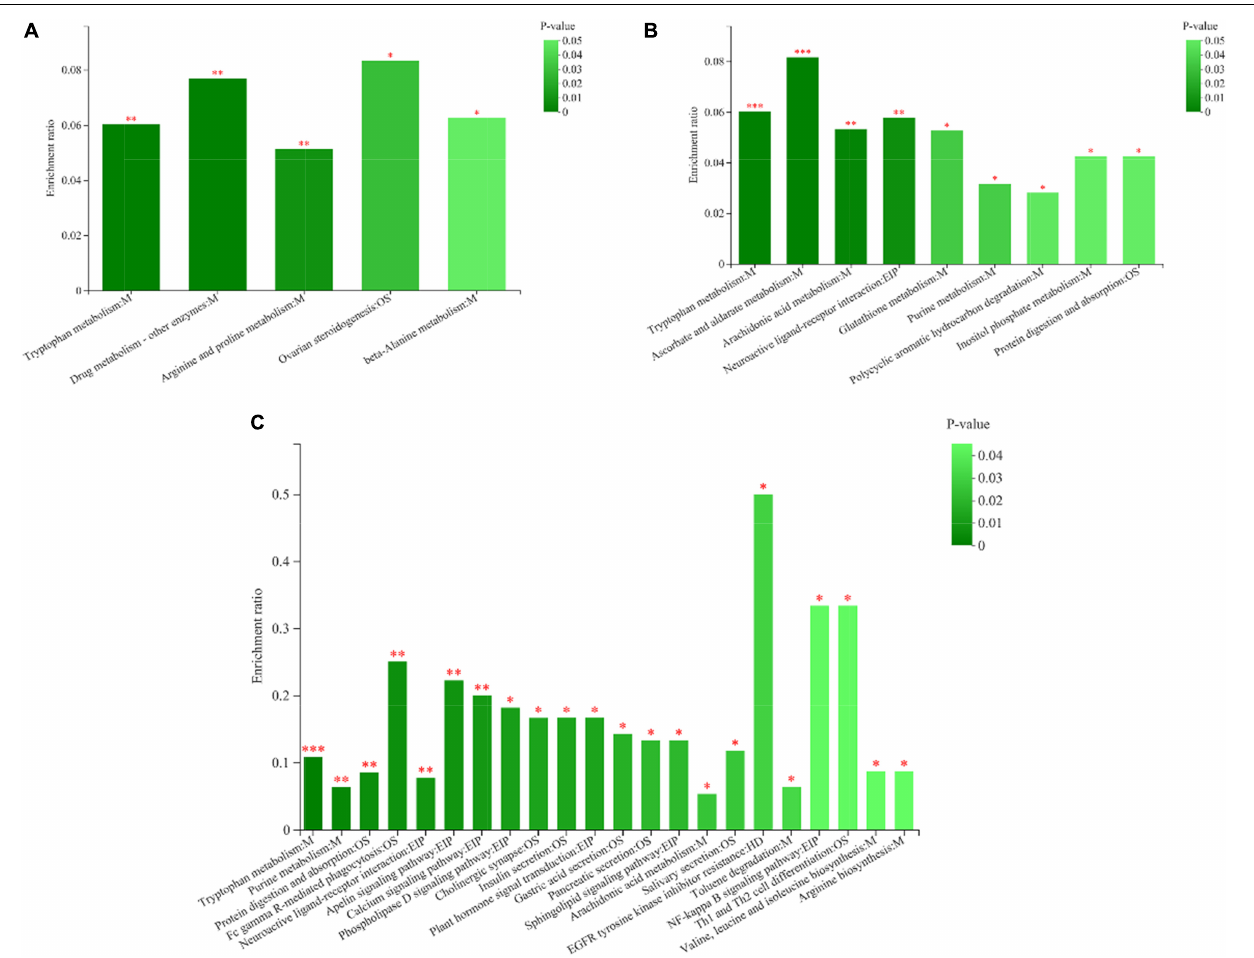
FIGURE 5 | Metabolic pathway enrichment analysis. (A) Pathway enrichment map of metabolites between yaks in groups C50 and C65. (B) Pathway enrichment map of metabolites between yaks in groups C50 and C80. (C) Pathway enrichment map of metabolites in yaks between groups C65 and C80. The abscissa indicates the pathway name. The ordinate represents the enrichment. The color gradient of the columns indicates the significance of the enrichment; the darker the color, the more significant the enrichment of the KEGG term. CP, EIP, GIP, HD, M, and OS are the class names of metabolic pathways in the KEGG annotation. CP, Cellular Processes; EIP, Environmental Information Processing; GIP, Genetic Information Processing; HD, Human Diseases; M, Metabolism; OS, Organismal Systems. C50, dietary concentrate-to-forage ratio 50:50; C65, dietary concentrate-to-forage ratio 65:35; C80, dietary concentrate-to-forage ratio 80:20. ∗ 0.01 < P ≤ 0.05; ∗∗ 0.001 < P ≤ 0.01; ∗∗∗ P ≤